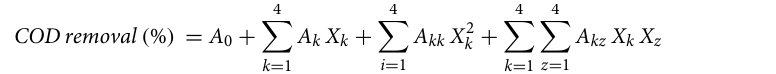
(molarity = 0.1). After conducting the adsorption tests, the adsorbent separates from the extract through 10 min of centrifugation at 4000 rpm (Denley BS400 machine, UK). The TDS (total dissolved solids), initial pH, and